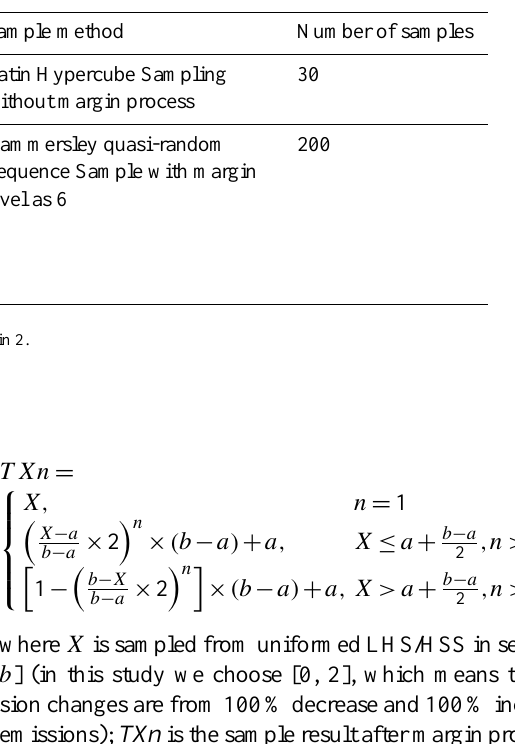
Table 2. Sample methods and key parameters used for ozone response surface